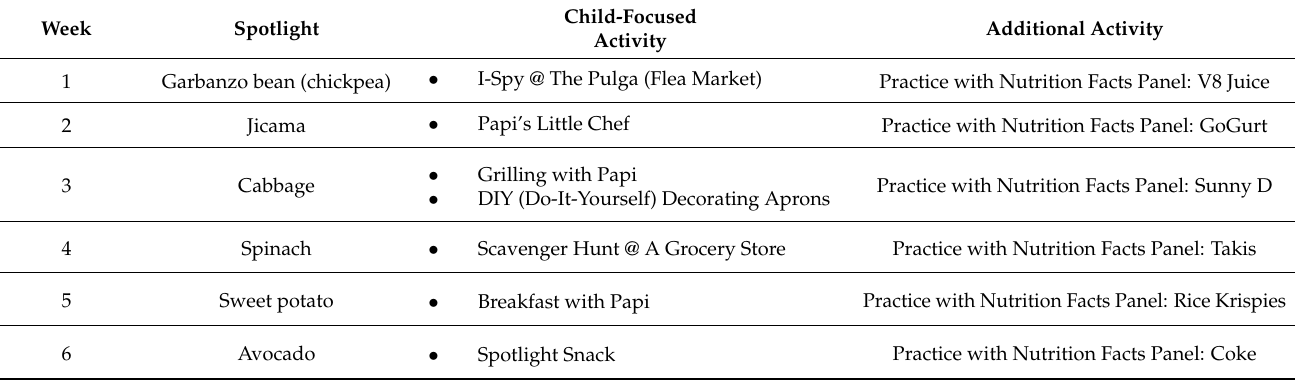
Table 6. At-home nutrition activities for children and parents from the farewell